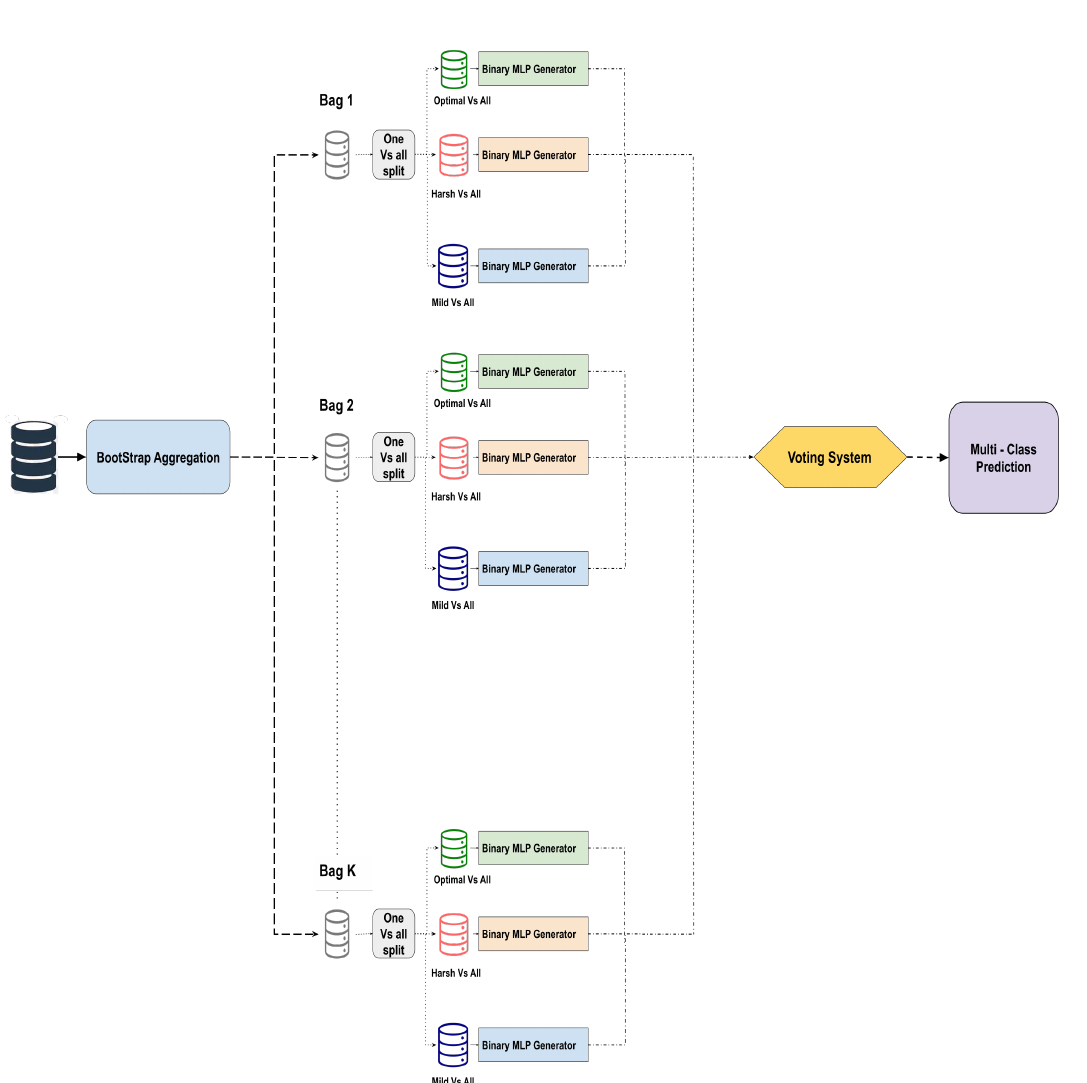
Figure 3. Multi-class MLP generator decision